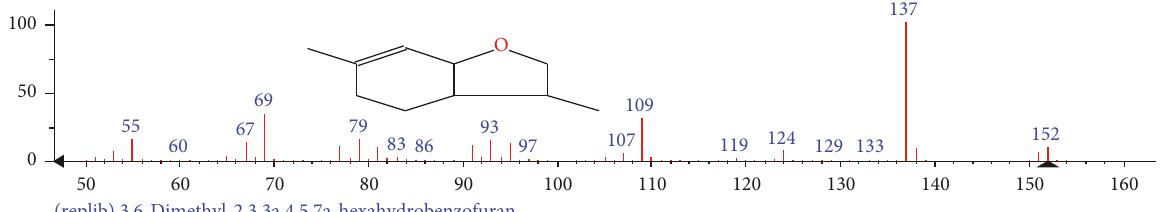
Figure 11: Mass spectrum of compound 3,6-dimethyl-2,3,3a,4,5,7a-hexahydrobenzofuran of whole plant hexane fraction of Achillea wilhelmsii (WHFAW).